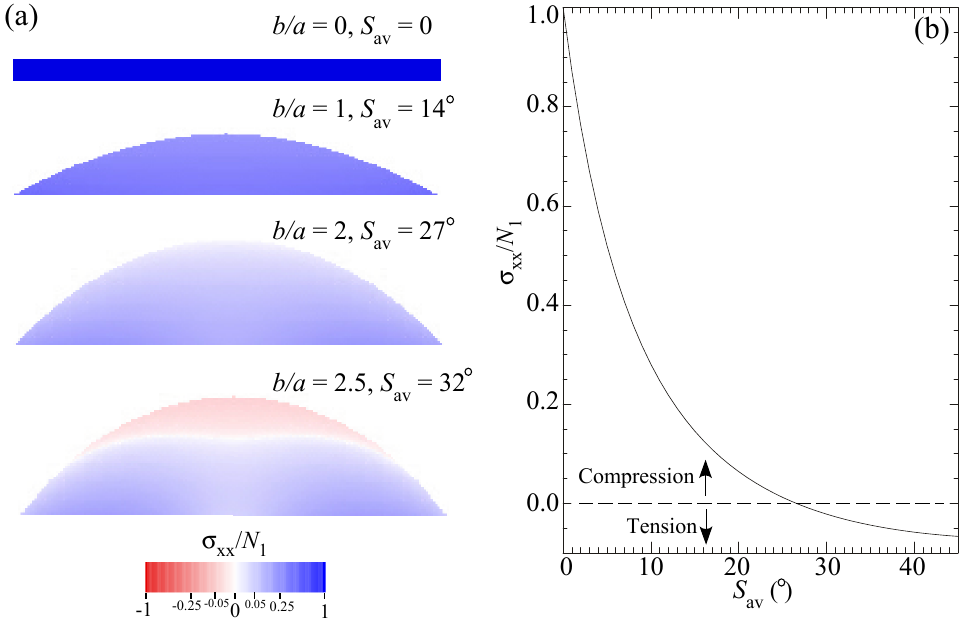
Figure 3. Analytic solutions illustrating the perturbation of a regional compressive-stress field by topography. (a) Color maps of the horizon- tal normal stress, σ xx (normalized to the regional stress, N 1 ), as a function of ridge steepness (defined by the shape factor b/a of Savage and Swolfs (1986) and the average slope S av ) using Eqs. (34) and (35) of Savage and Swolfs (1986). The hillslopes are plotted with no vertical exaggeration. (b) Plot of σ xx directly beneath the ridge as a function of S av using Eq. (36) of Savage and Swolfs (1986). The plot illustrates the decrease in compressive stress with increasing average slope and the transition to tensile stresses at an S av value of approximately 27 ◦